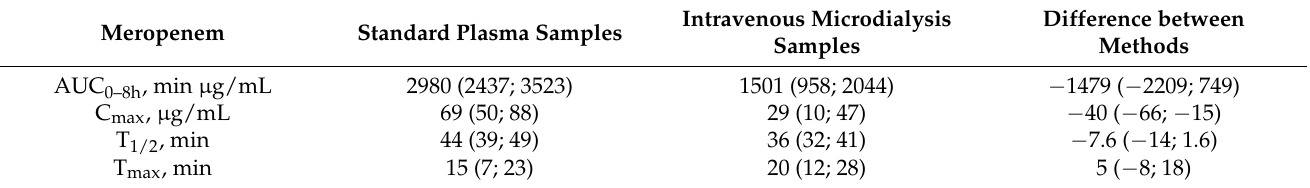
Table 2. Pharmacokinetic comparison between standard plasma samples and intravenous microdial- ysis samples for meropenem.